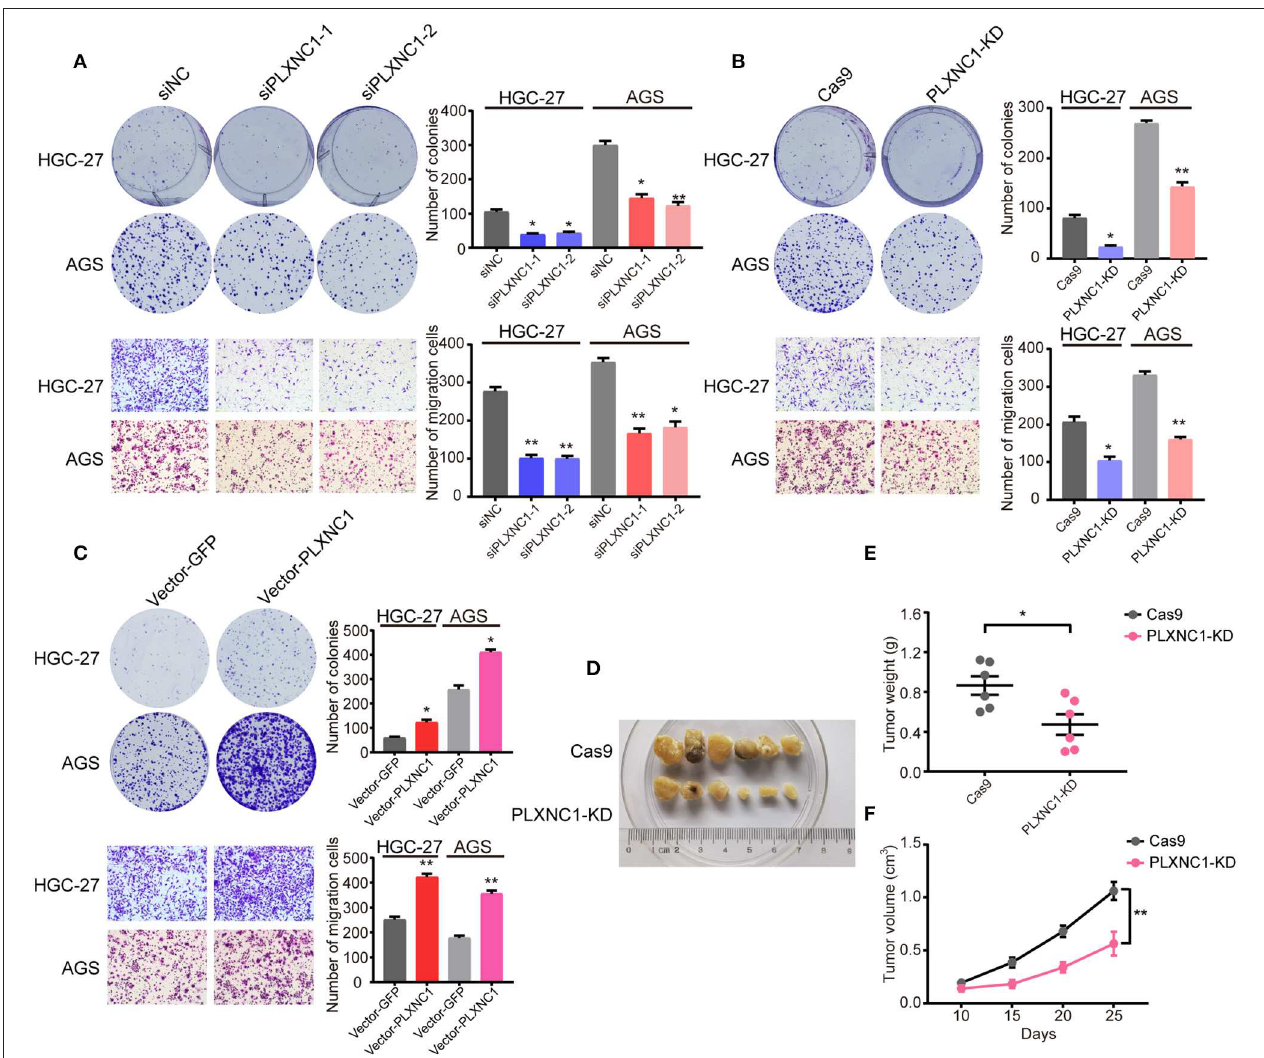
FIGURE 3 | PLXNC1 plays oncogenic roles in gastric cancer both in vitro and in vivo . (A) Colony formation assays (up) and Transwell migration assays (down) for HGC-27 and AGS cells transfected with PLXNC1 siRNAs or negative control (NC) siRNA. (B) Colony formation assays (up) and Transwell migration assays (down) for HGC-27 and AGS cells infected with the PLXNC1 knockdown-mixed sgRNAs or control sgRNA lentivirus. (C) Colony formation assays (up) and Transwell migration assays (down) for HGC-27 and AGS cells infected with PLXNC1 overexpression lentivirus or GFP control. (D) Xenograft tumors of Cas9 or PLXNC1 knockdown AGS cells in nude mice. (E,F) The knockdown of PLXNC1 reduces the (E) weight and (F) volume of xenograft tumors ( n = 6 mice per group). Values represent the mean ± SEM, (A–C) n = 3 and (D–F) n = 6. * P < 0.05; ** P <